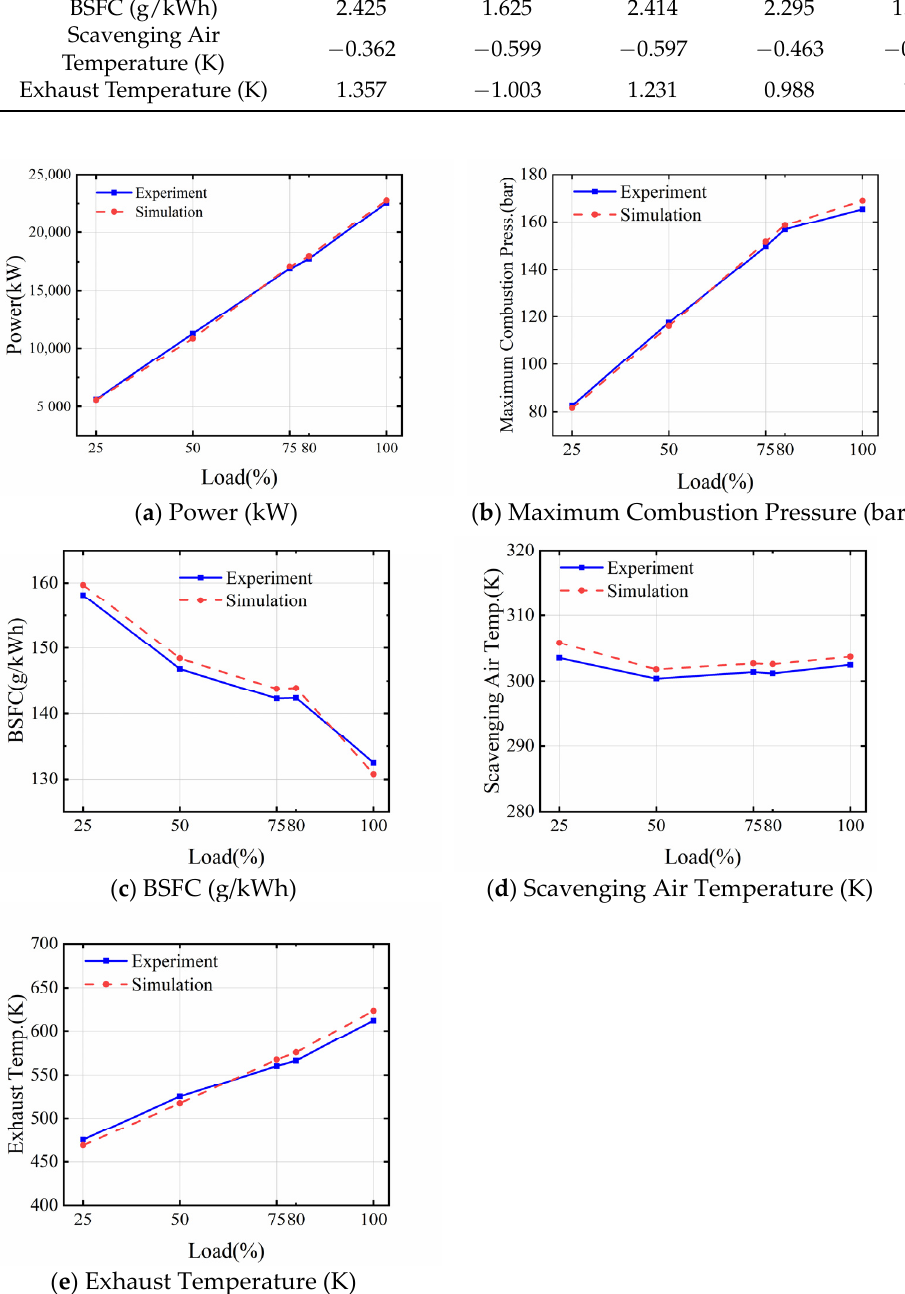
Figure 5. Comparison of simulation and experiment in gas mode.